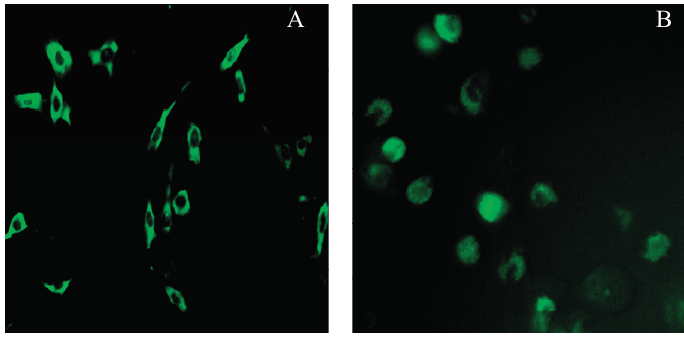
Figure 7. NIH-3T3 cells and pig SSCs (spermatogonial stem cells) transiently expressing EGFP-N1- Stra8 . ( A ) NIH-3T3 cells transfected with pEGFP-N1- Stra8 ; ( B ) Pig SSCs transfected with pEGFP-N1- Stra8